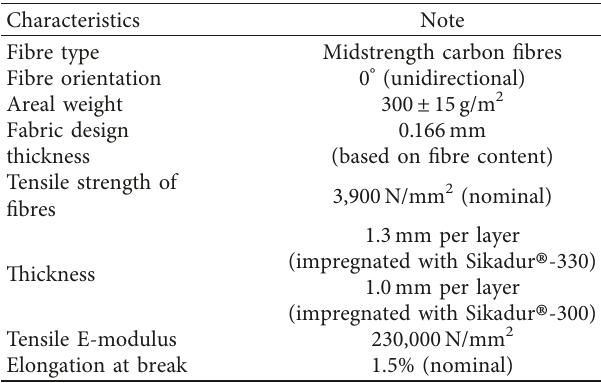
Table 2: SikaWrap ® -300C (woven carbon fibre fabric for structural strengthening).